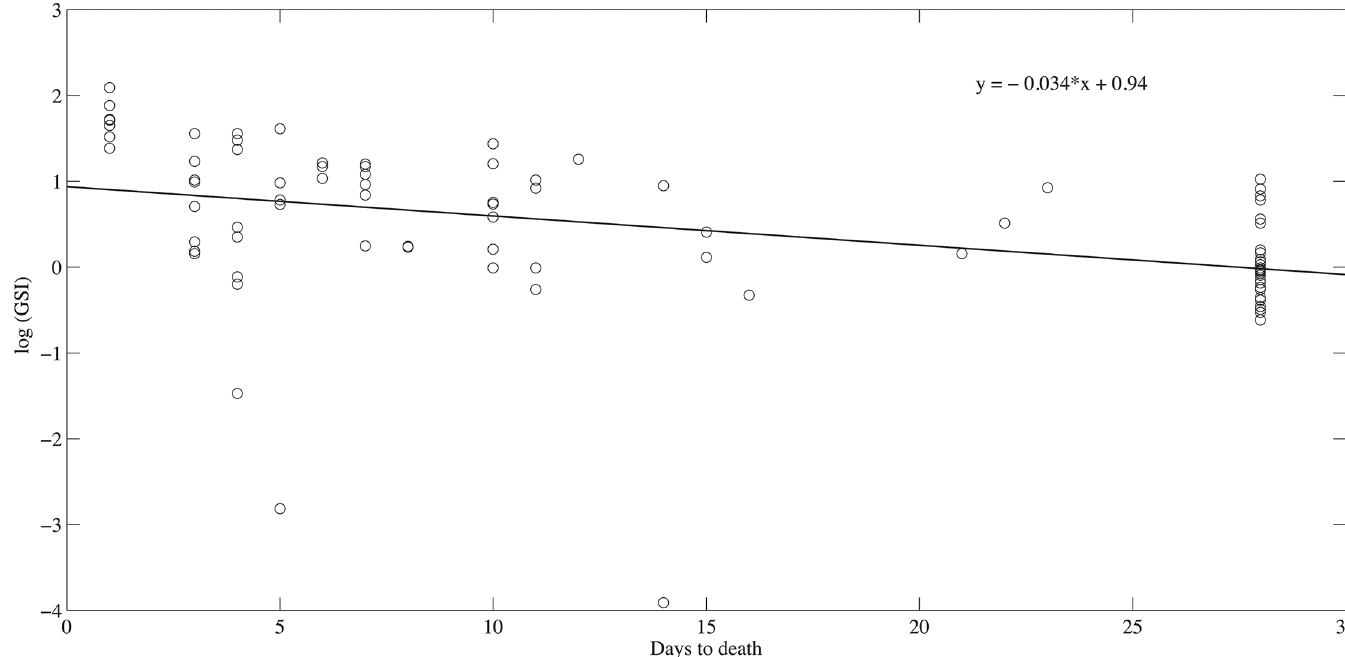
Fig 7. The relationship between the log(GSI) and days to death. The fitted line is the linear regression